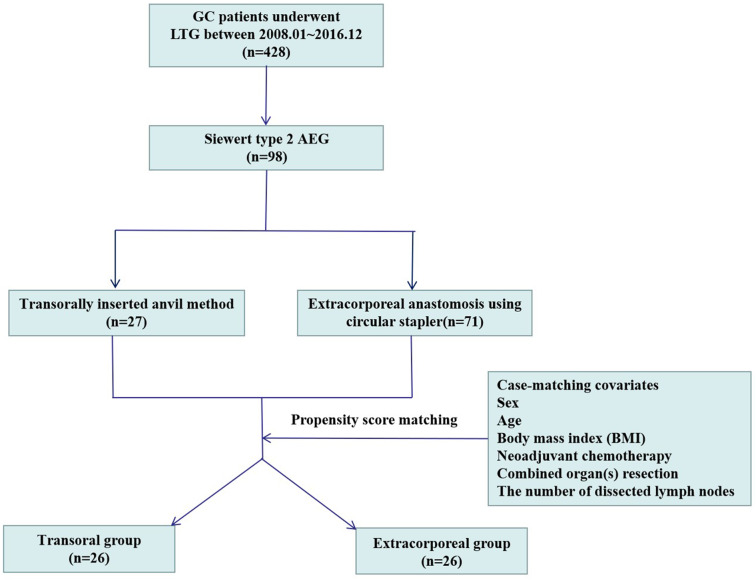
Selection and grouping of stomach-predominant Siewert type 2 adenocarcinoma of esophagogastric junction patients.